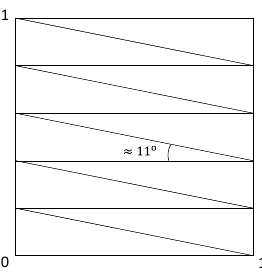
Figure 9. Domain problem for the second numerical experiment, and coarsest grid consist- ing of 10 triangles.